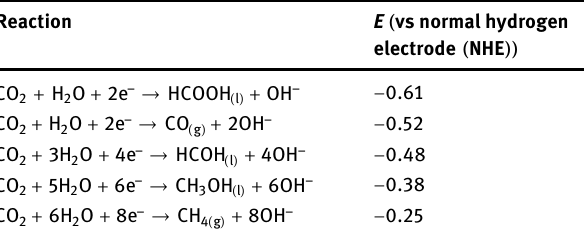
Table 1: Reduction potentials at pH 7 of some CO 2 reduction reac - tions in aqueous solution